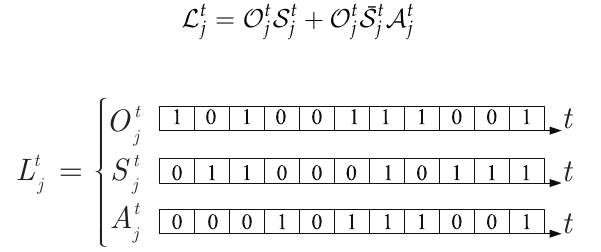
Figure 5. An example of L t